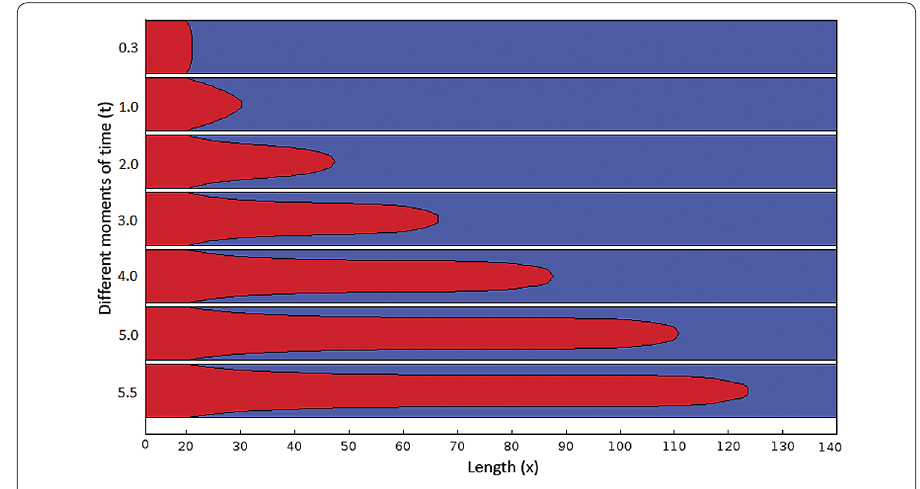
Figure 1 Numerical simulation: successive positions of the free boundary in a single capillary. Due to the boundary condition (18), the contact points of the free boundary and the solid skeleton will be permanently fixed at the initial position. Numerical implementations predict the appearance of a water tongue, which grows with